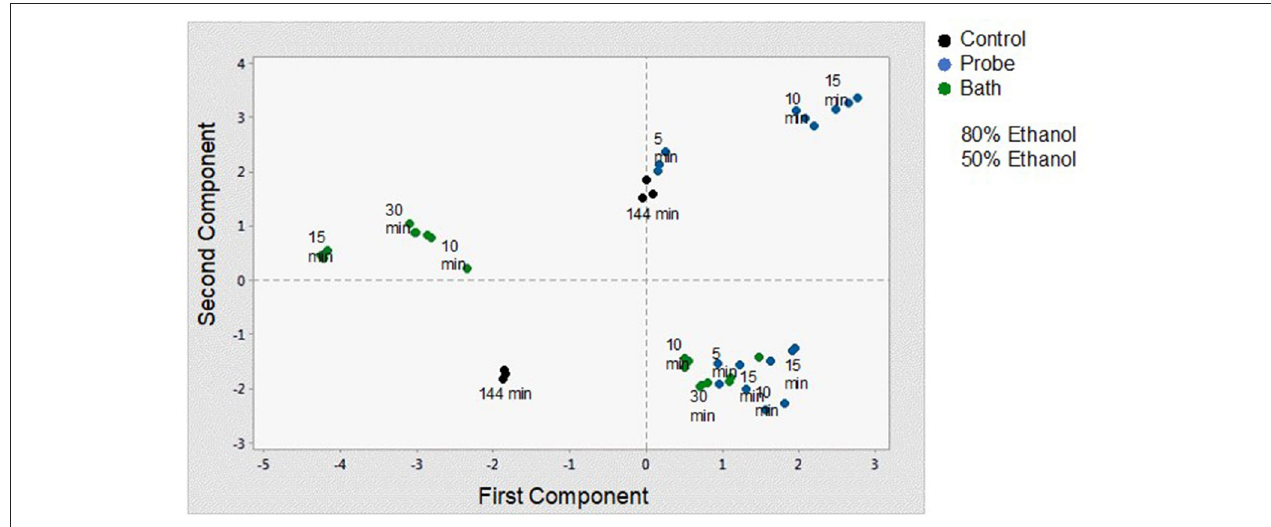
FIGURE 7 | Score plot for the principal components